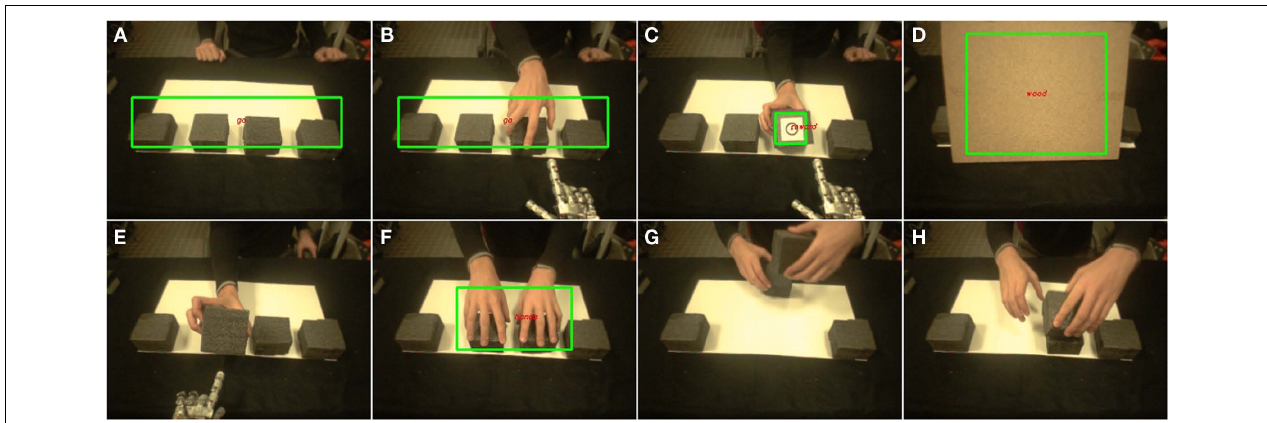
problem, the human could hide the cubes with a wooden board (D) , and changed the position of the rewarded cube. In early stages, this was followed by an error (E) . Once the robot learned the appropriate meta-value of the board, the human could cheat by unexpectedly changing the reward location (F–H)